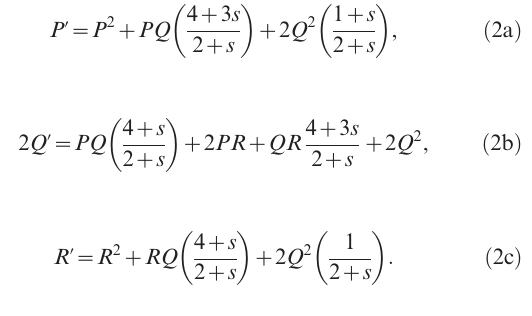
Table 1. Genotype frequency in next generation.